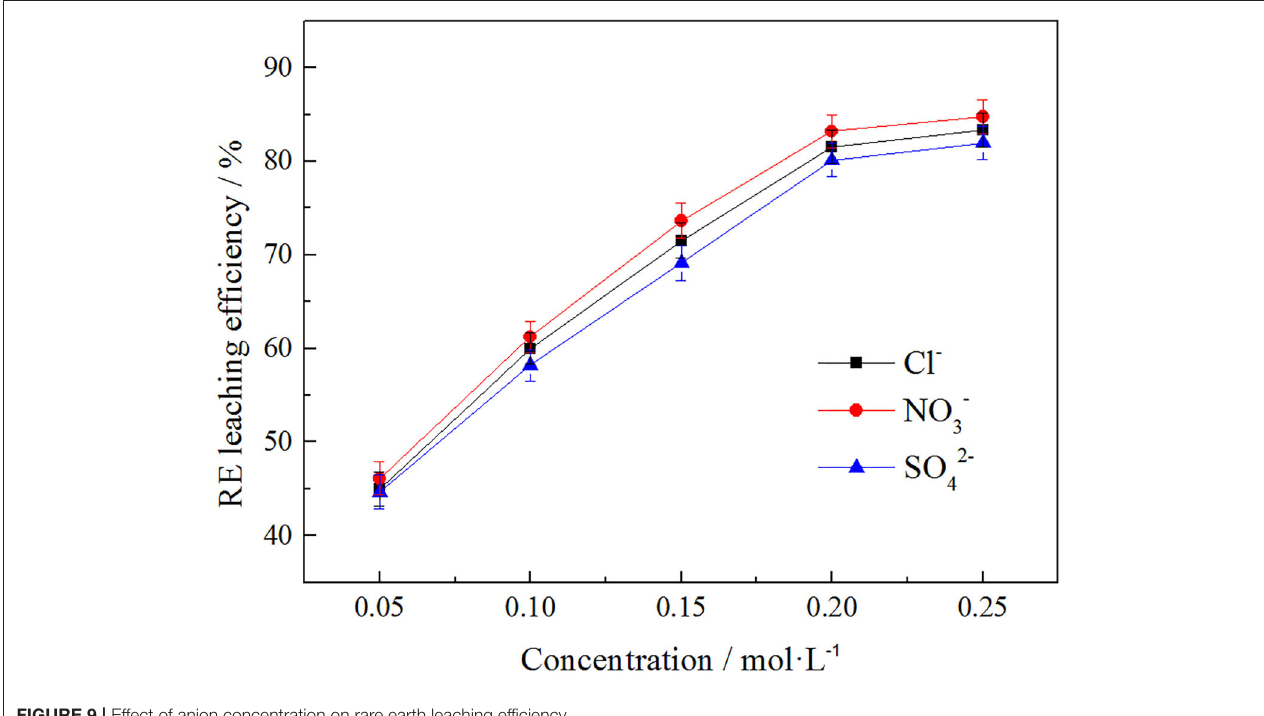
FIGURE 9 | Effect of anion concentration on rare earth leaching efficiency.